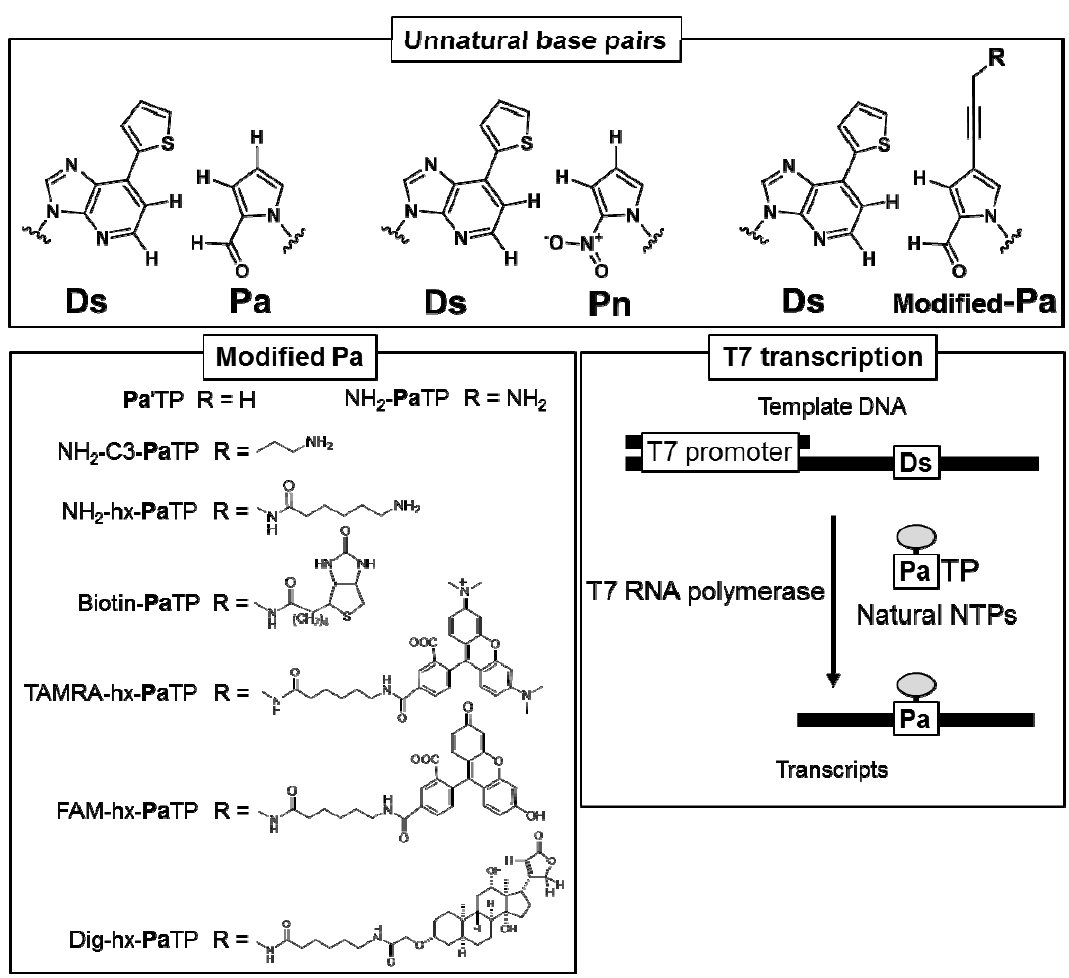
Figure 1. Chemical structures of unnatural base pairs used for T7 transcription in this study. A variety of substituent groups can be attached to the Pa base moiety. The scheme of T7 transcription mediated by the unnatural Ds – Pa pair is shown (lower